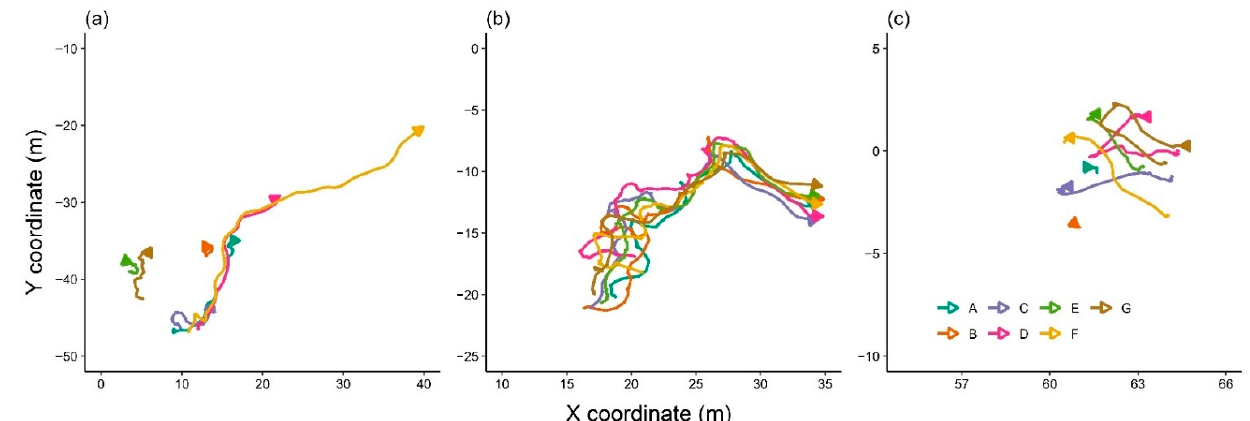
Figure 5. Some examples of individual animal movement behaviour at 10 min intervals on the second day of the study to rank the animals based on their movement trajectories and select the animal (s) who moved first. Plot ( a ) shows where all individuals were assigned a different rank, ( b ) shows where all individuals received the same rank, ( c ) shows where one animal (B) did not move. Individual animals are represented by separate colours and letters (A to G), and the direction of the arrow indicates the direction of travel at the conclusion of the 10 min period. The length of the lines indicates the distance travelled. For clarity, the specific paddock area the animals were within is displayed, hence the different axis values for each plot.